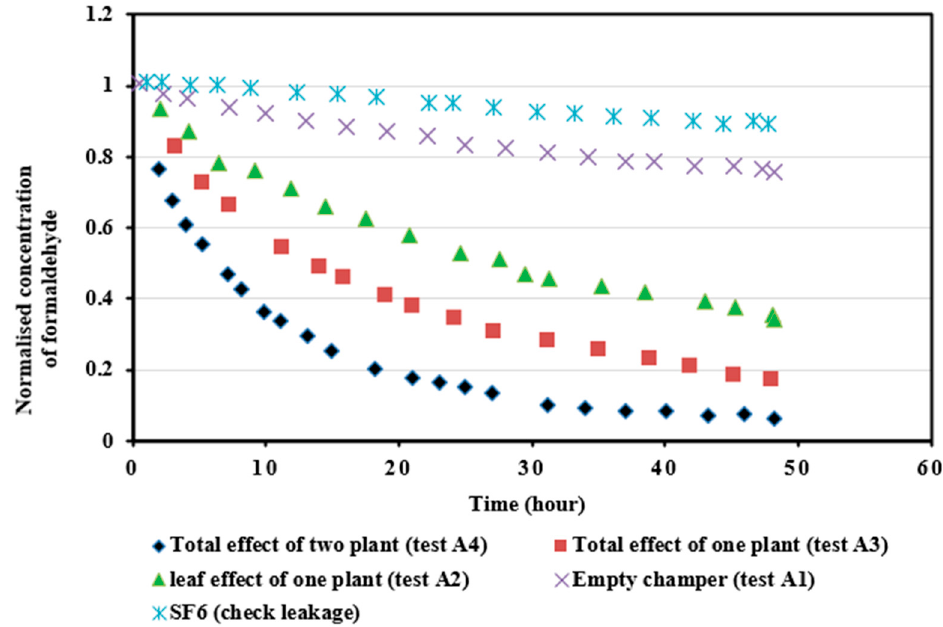
Figure 5. Formaldehyde removed by a static potted plant, formaldehyde concentration 10 ppm [133] .